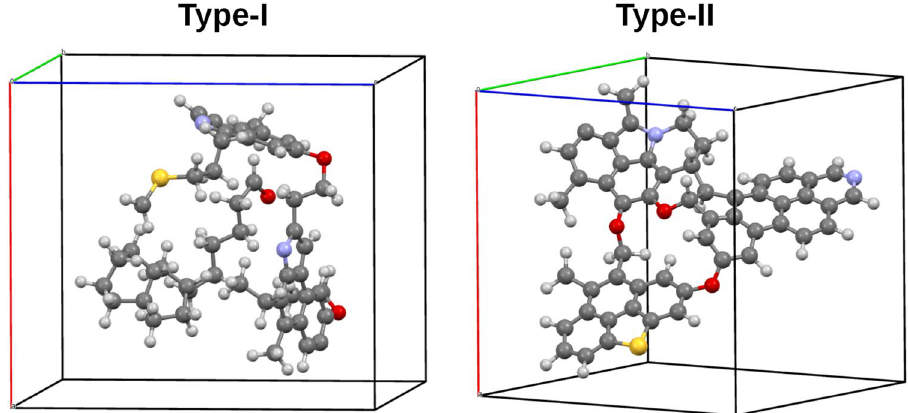
Figure 1. Structures of 3D-periodic type-I (left) and type-II (right) kerogen models used in DFT/DFPT calculations at the GGA/PBE level of theory. The simulation cells are indicated by solid lines. Color legend: grey, C; white, H; purple, N; red, O; yellow,